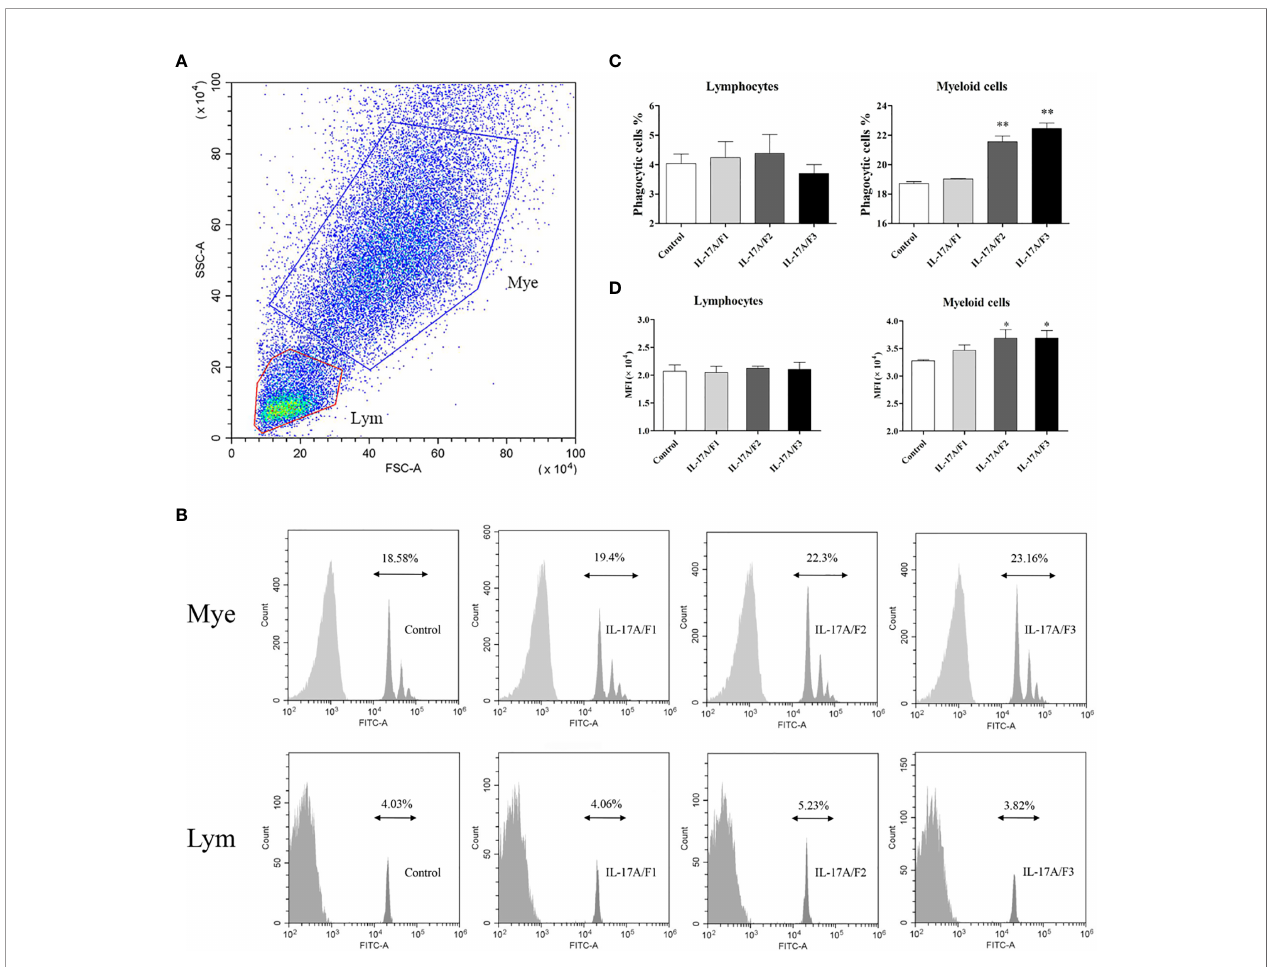
FIGURE 8 | The r Pf _IL-17A/F1, 2 and 3 promote phagocytosis of PBLs in yellow cat fi sh. (A) Cell typing of PBLs by fl ow cytometry analysis. Yellow cat fi sh PBLs were incubated with r Pf_ IL-17A/F1, IL-17A/F2 and IL-17A/F3 proteins (500 ng/mL) or medium alone as a control for 18 h. The PBLs were then incubated with 1.0 µm fl uorescent beads for 2 h and analyzed by fl ow cytometry. Mye: myeloid cells, Lym: lymphocytes. (B) The phagocytic activity of PBLs detected by fl ow cytometry. Typical results from a biological replication experiment are shown. (C) The percentage of phagocytic leukocytes in lymphocytes and myeloid cells. (D) The mean fl uorescence intensity (MFI) of phagocytic cells. The PBLs were isolated from three individuals of yellow cat fi sh and were mixed equally, and the pooled sample was further divided into four experiment units for different experimental treatments. Columns and deviation bars represent the means and standard errors for each treatment ( n = 3), respectively. Signi fi cant difference in different protein treatments compared to the control is indicated by asterisks (* P < 0.05, ** P <